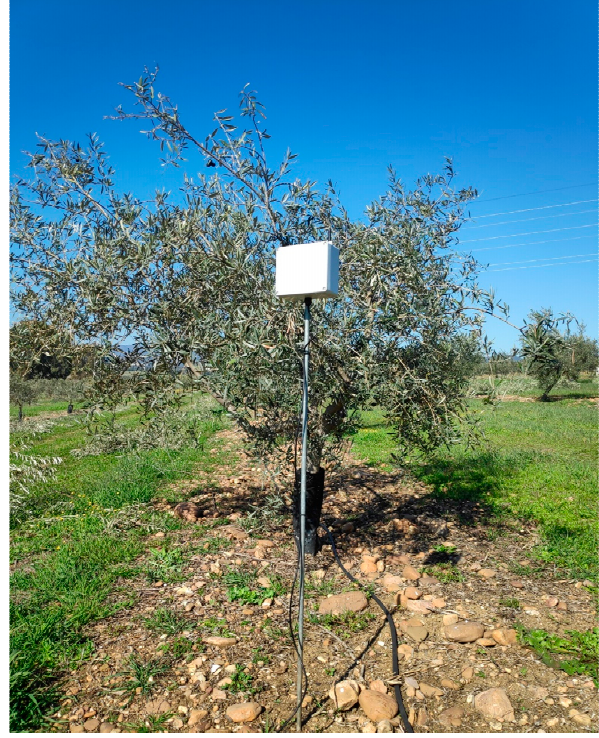
Figure 10. Field monitor node.